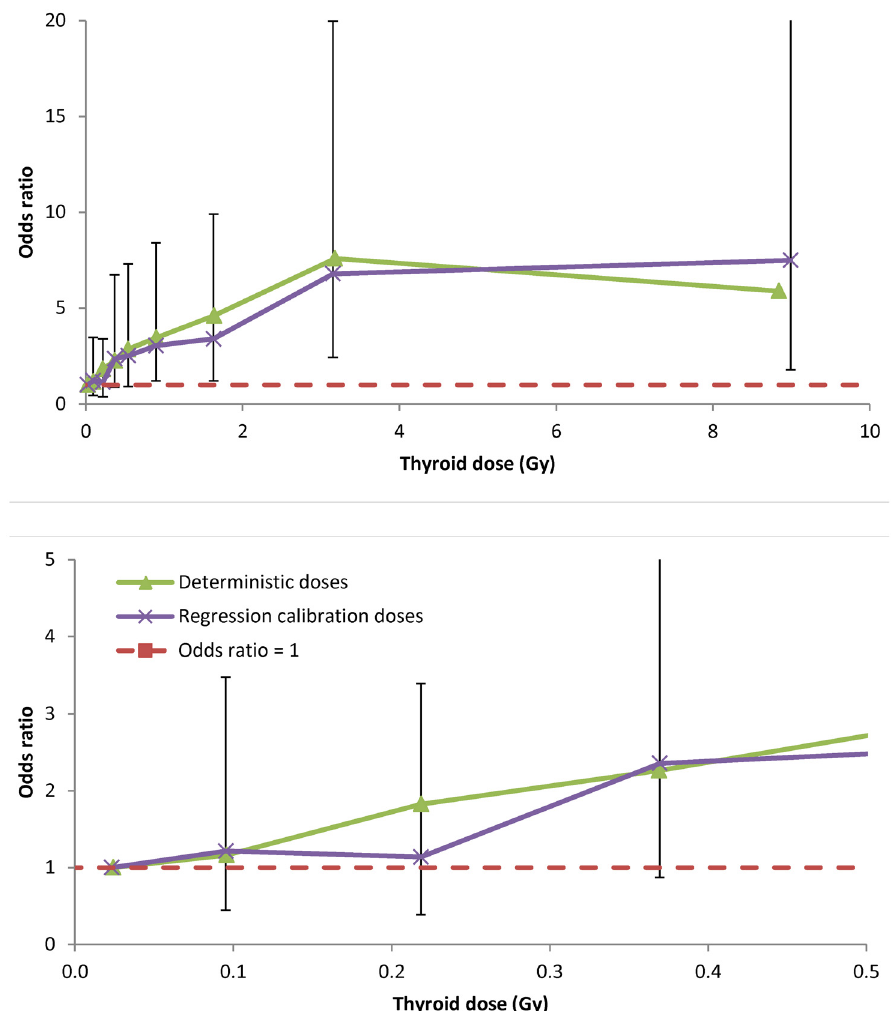
Fig 1. Dose-response (+95 CI) for thyroid cancer in relation to deterministic [4, 21], and regression- calibration adjusted doses (arithmetic means of 1,000 individual stochastic doses) [22]. The models are adjusted for age (treated categorically), gender and oblast in the baseline. Dashed red line shows odds ratio = 1. The lower panel shows the lower dose ( < 0.5 Gy) part of the dose